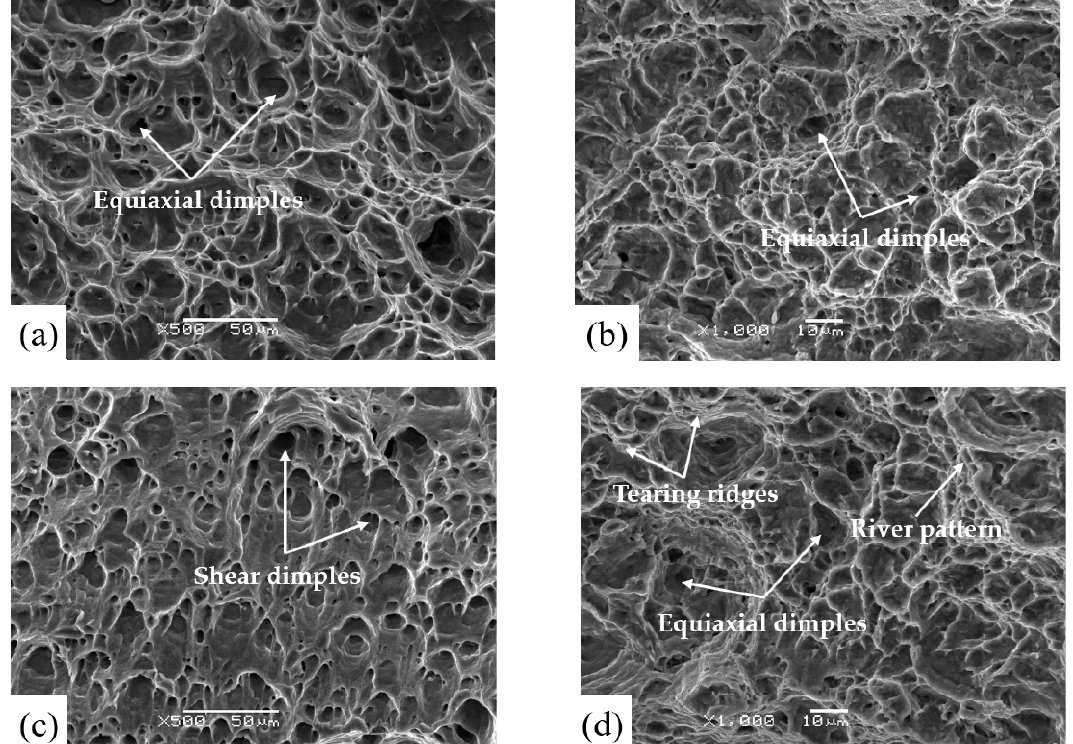
Figure 8. SEM (scanning electron microscopy) diagrams of fractures: ( a ) fracture in 1060 in sample 1; ( b ) fracture in TA2 in sample 1; ( c ) fracture in 1060 in sample 2; ( d ) fracture in TA2 in sample 2.